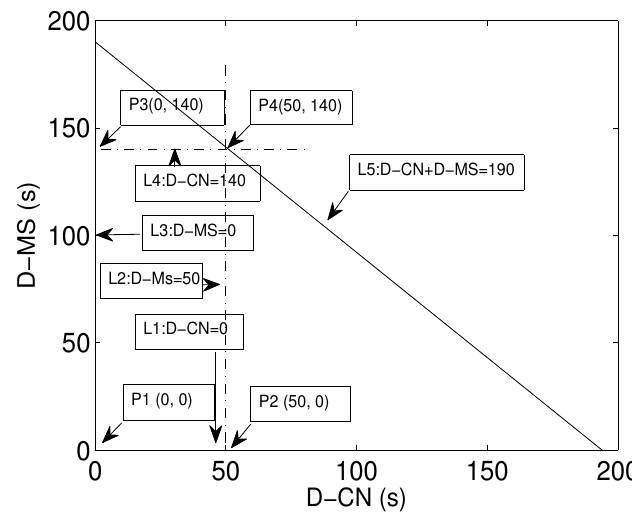
Figure 6. Delay: feasible